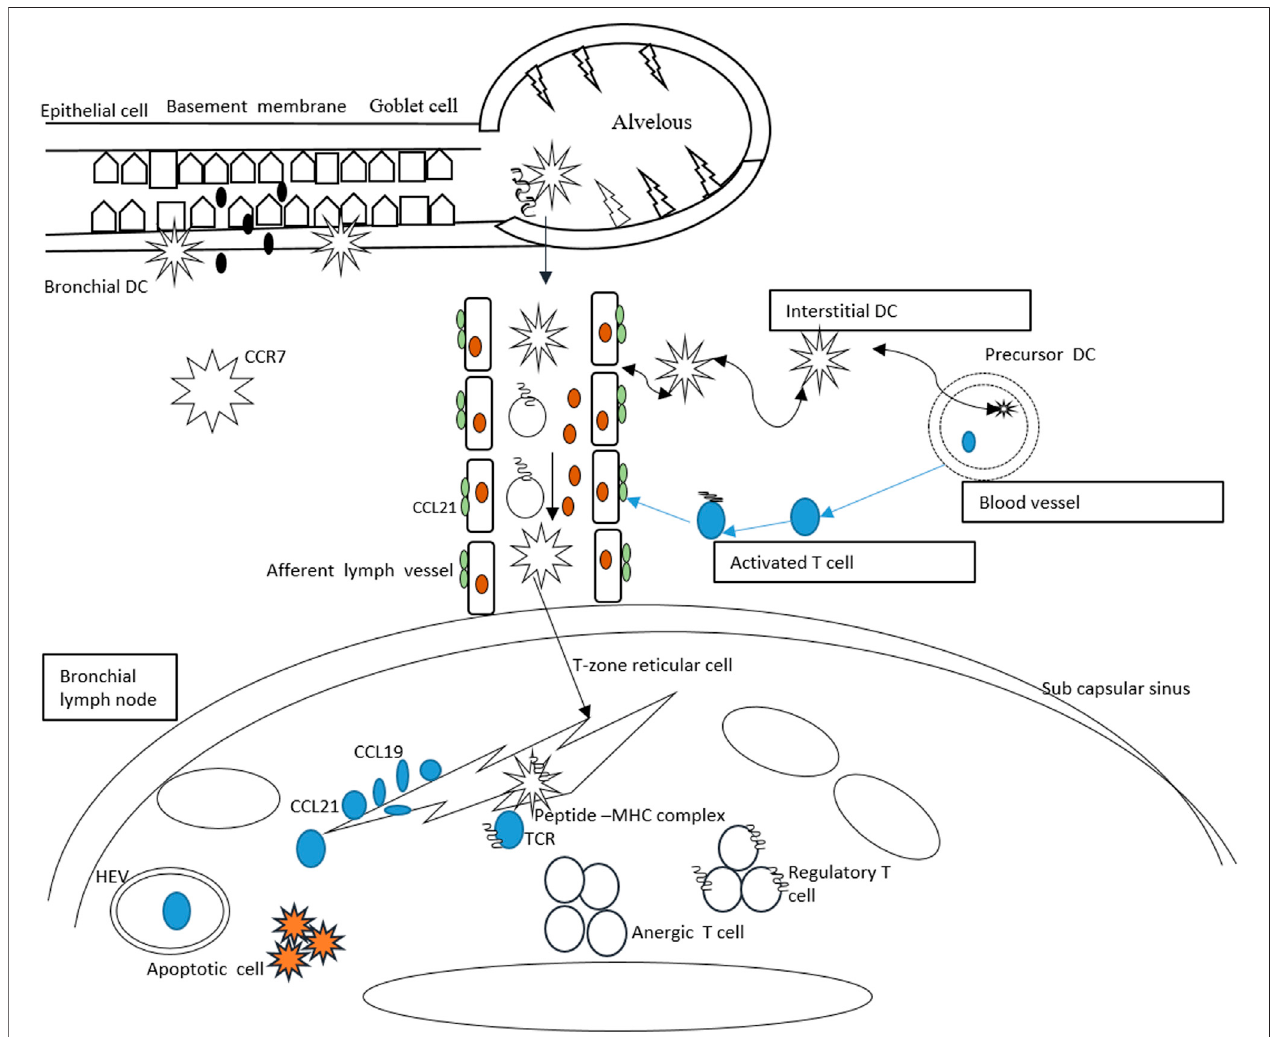
FIGURE2| CCR7-mediated tolerance inresponse toinhaled antigens. Thedendritic cells enterthelungs and produce interstitialand bronchialdendritic cells. The bronchialdendriticcellscarrytheantigensandupregulatetheCCR7andmovetowardlymphaticvesselstoactivateCCL21.Thedendriticcellsarepassivelytransported intothedraininglymphnode.ThedendriticcellsthenpresentantigenstothenaïveT-cellsand via endothelialvenules,theT-cellspenetrateintothelymphnode.Migration of T-cells on reticular cells results in expression of CCL19/21.